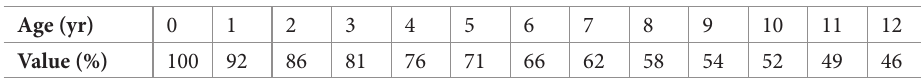
Table 3. Used aircraft, average loss of value with age Age (yr)